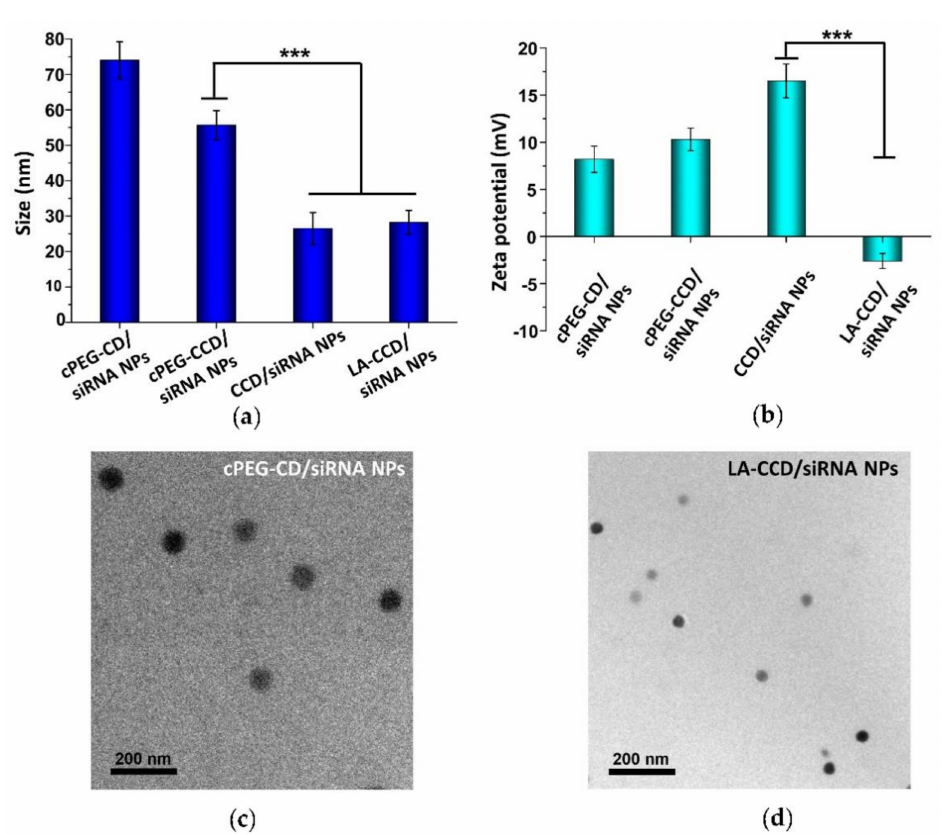
Figure 12. Particle sizes ( a ) and zeta potentials ( b ) of cPEG-CD/siRNA NPs, cPEG-CCD/siRNA NPs, CCD/siRNA NPs, and LA-CCD/siRNA NPs. Data are shown as the mean ± SD (n = 3). *** p < 0.001. Transmission electron microscope (TEM) images of cPEG-CD/siRNA NPs ( c ) and LA-CCD/siRNA NPs ( d